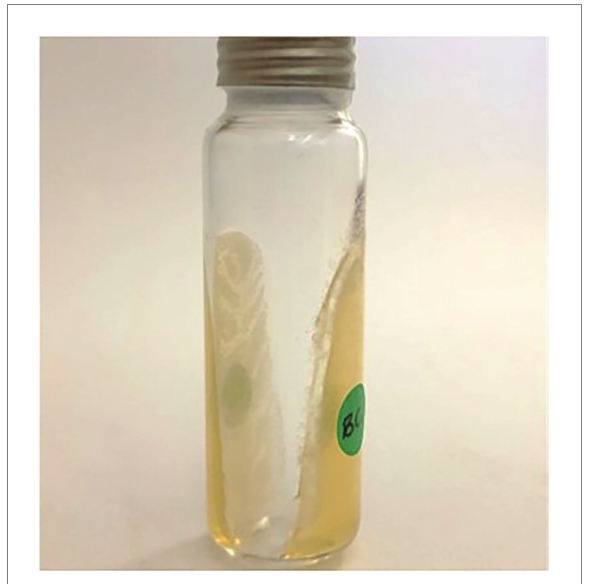
FIGURE 2 Headspace vial with YPD-L agar for automated sampling of volatile organic compounds produced by antagonistic yeasts in the presence of Botrytis cinerea IWBT